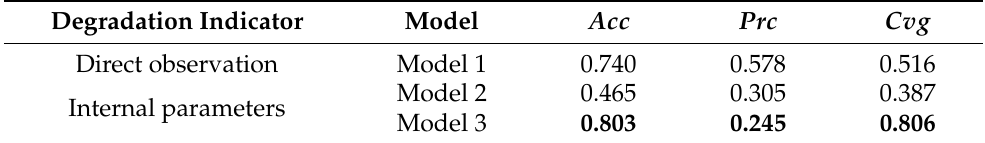
Table 2. Prognostic performance evaluation